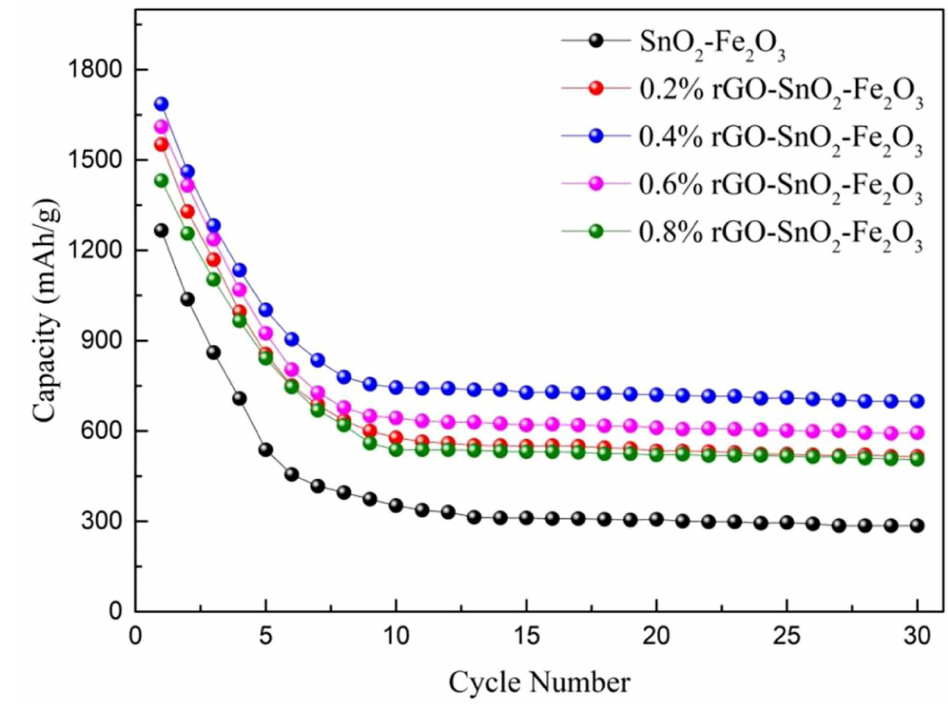
Figure 3. Cyclic performance of rGO-SnO 2 -Fe 2 O 3 composites.